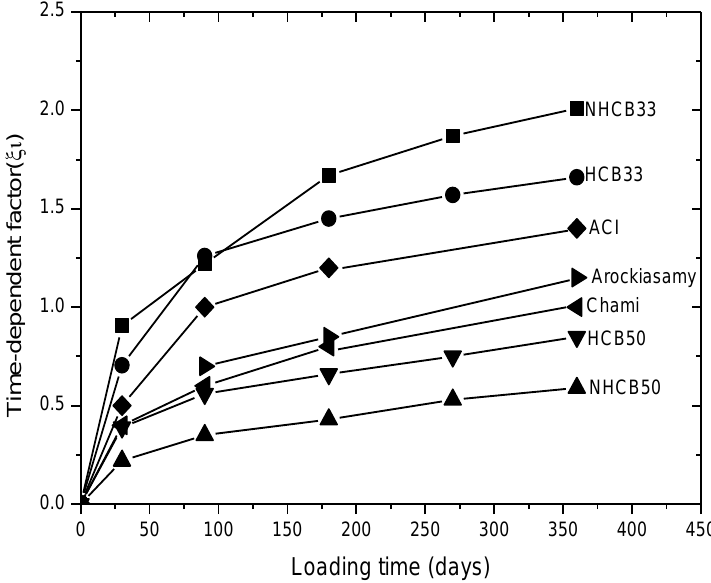
ξ ) under sustained